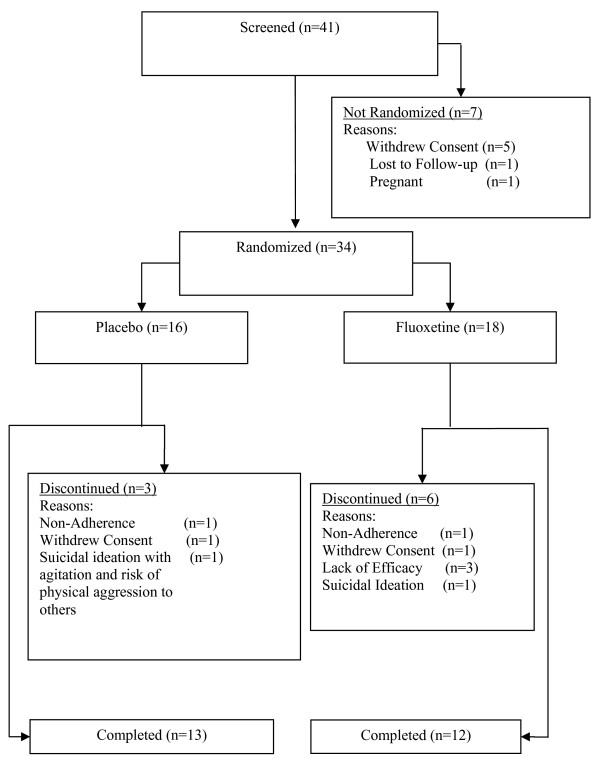
Patient disposition.